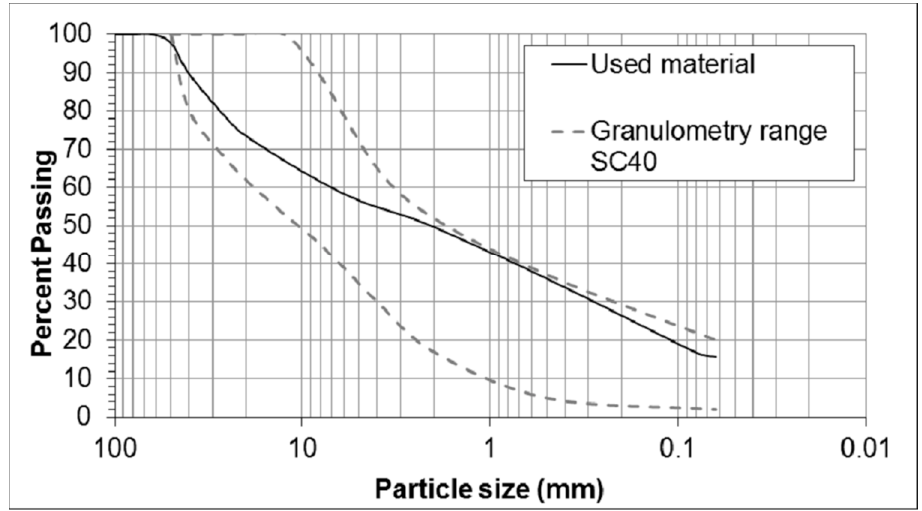
Figure 3. Soil granulometry and granolumetry range for SC 40.